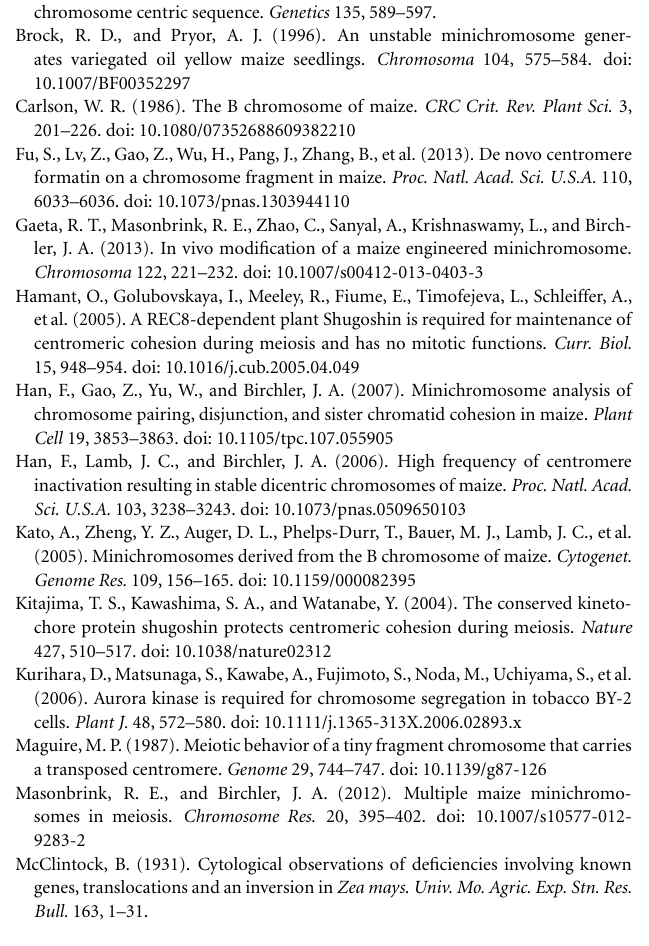
FIGURE 4 | Cytological analysis of two copies of a minichromosome. Arrows indicate that the two dicentric minichromosomes do not pair with each other. ZmBs is red and green is knob heterochromatin. Bars = 10 μ m.